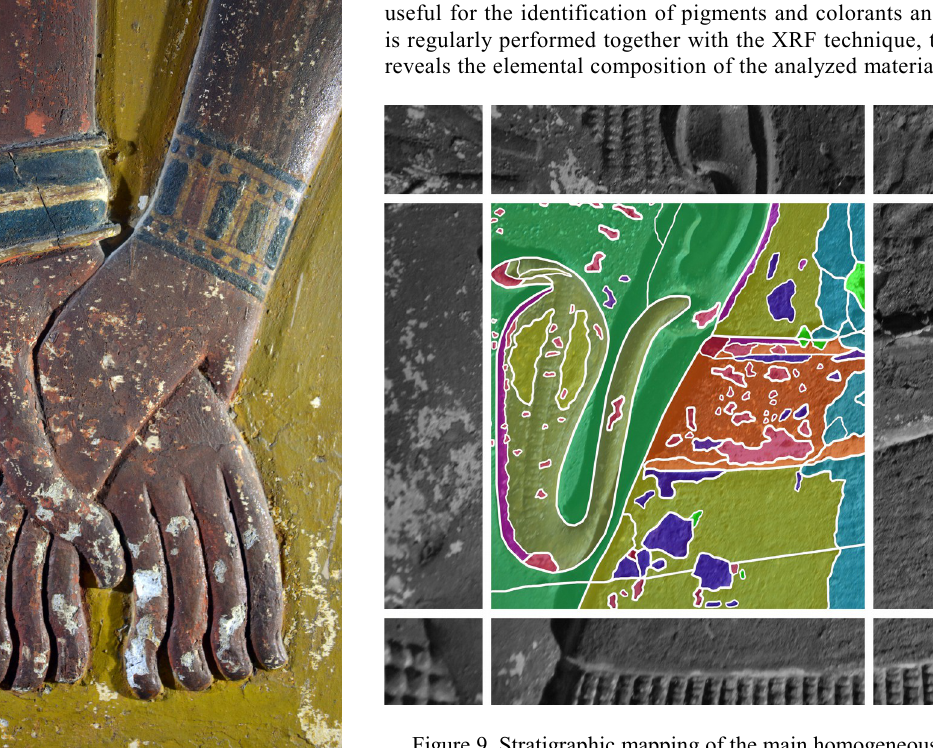
Figure 9. Stratigraphic mapping of the main homogeneous portions on the sample